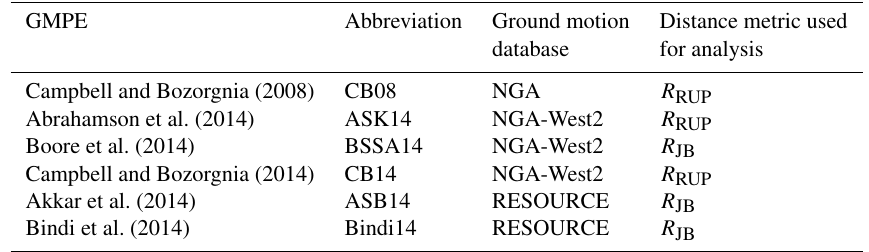
Figure 8. Logic tree for model 5, showing the main branches of the linear sources (a) and the background polygon (b) . Where a weight is not assigned, the analysis was conducted separately for each alternative. Table 4. The GMPEs used for analysis and their associated ground motion